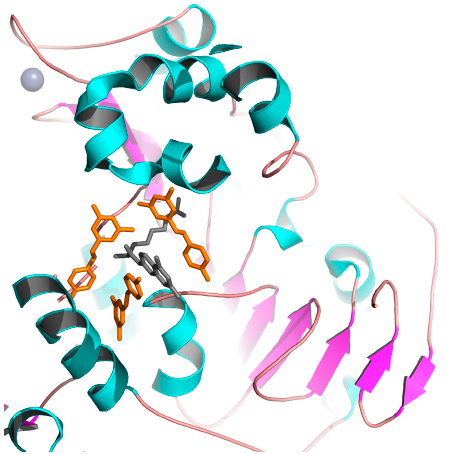
Figure 7. Crystal structure of human SIRT1 in complex with resveratrol (shown in orange) and 7-amino-4-methylcoumarin containing peptide (shown in grey). The zinc ion is shown as a grey sphere. The figure was created using the program PyMOL (www.pymol.org).